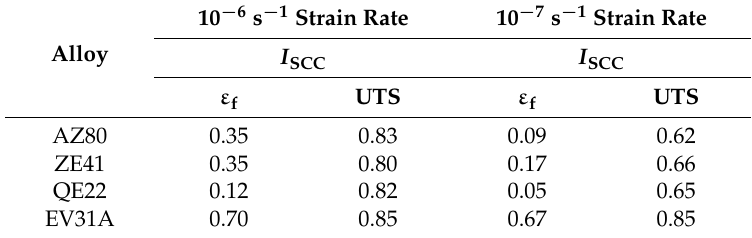
Table 4. I SCC indices for different alloys at different strain rate. Modified from [158].